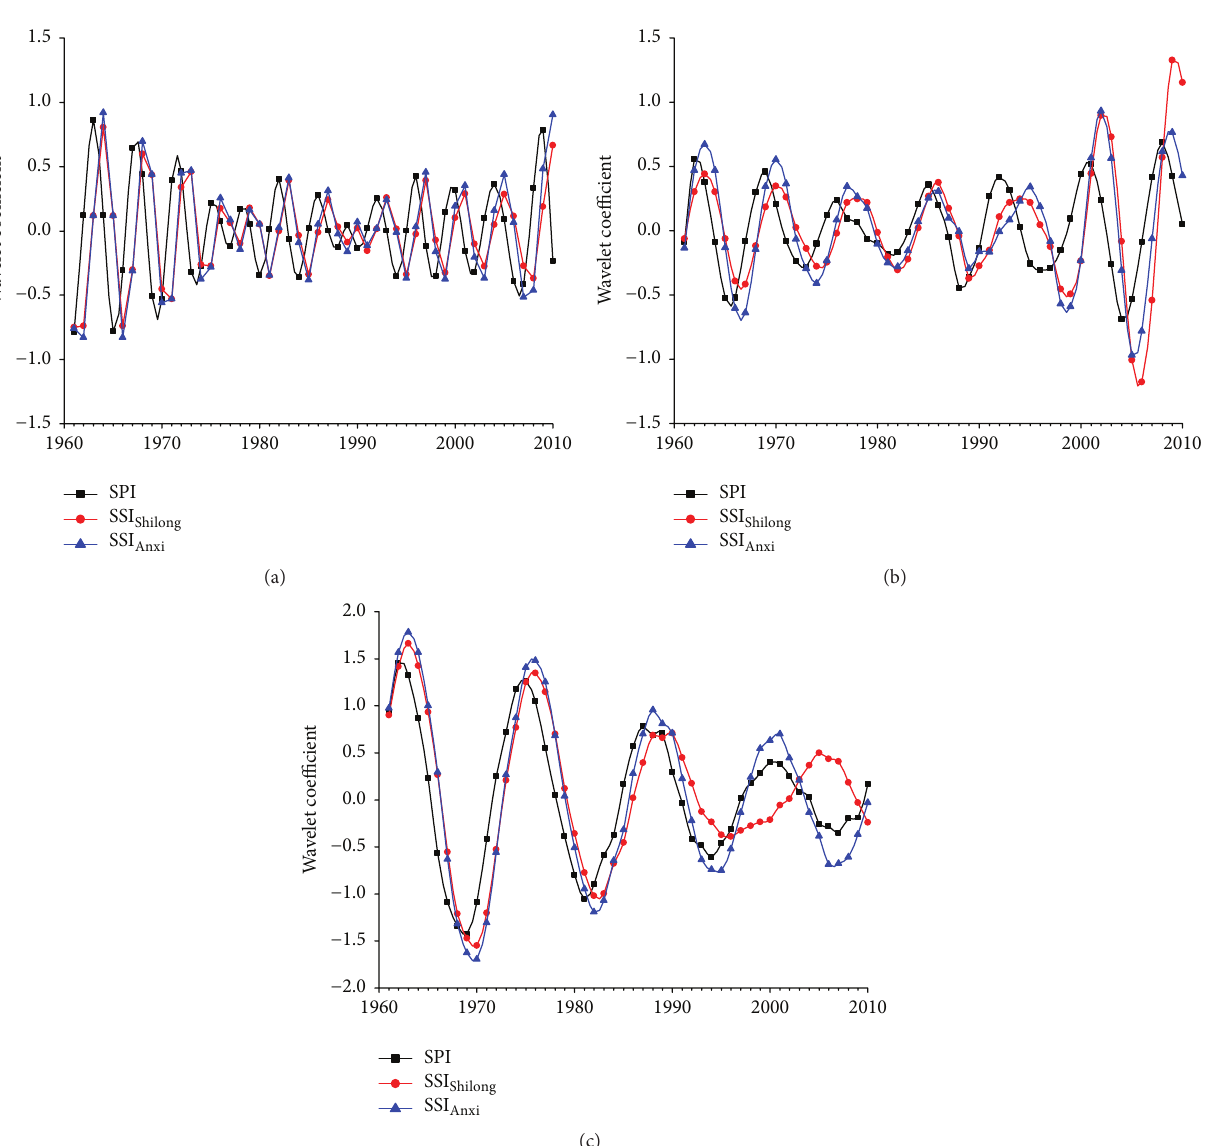
Figure 4: Comparison of main periodic oscillations change between SPI and SSI: (a) 6-7 years, (b) 11-12 years, and (c) 20-21 years.